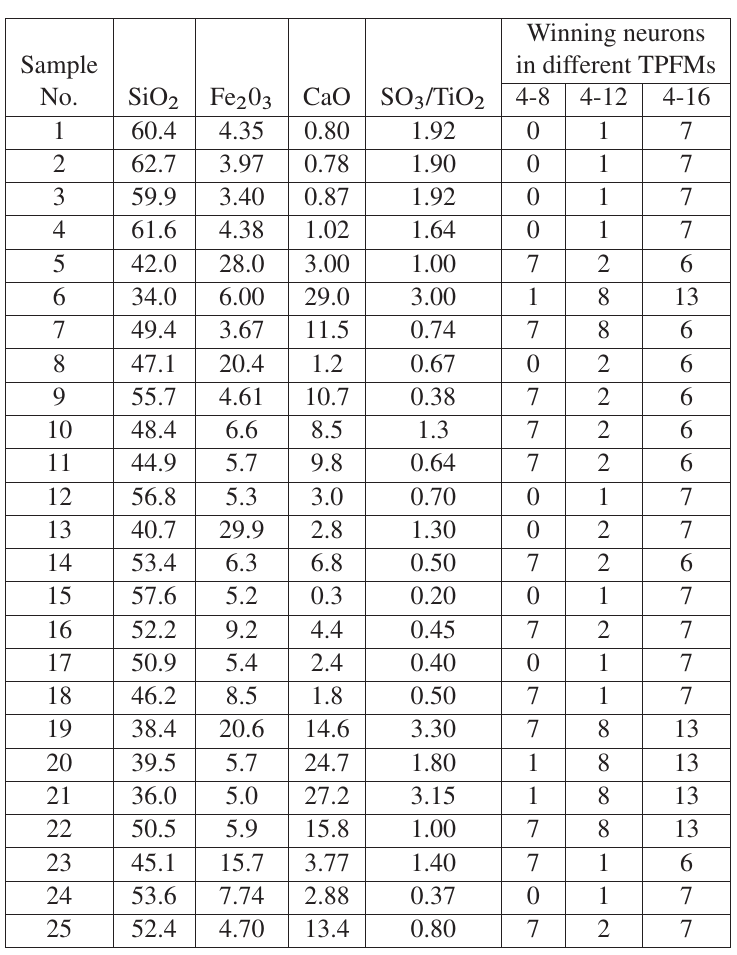
Table 4. SOFM winning neurons.